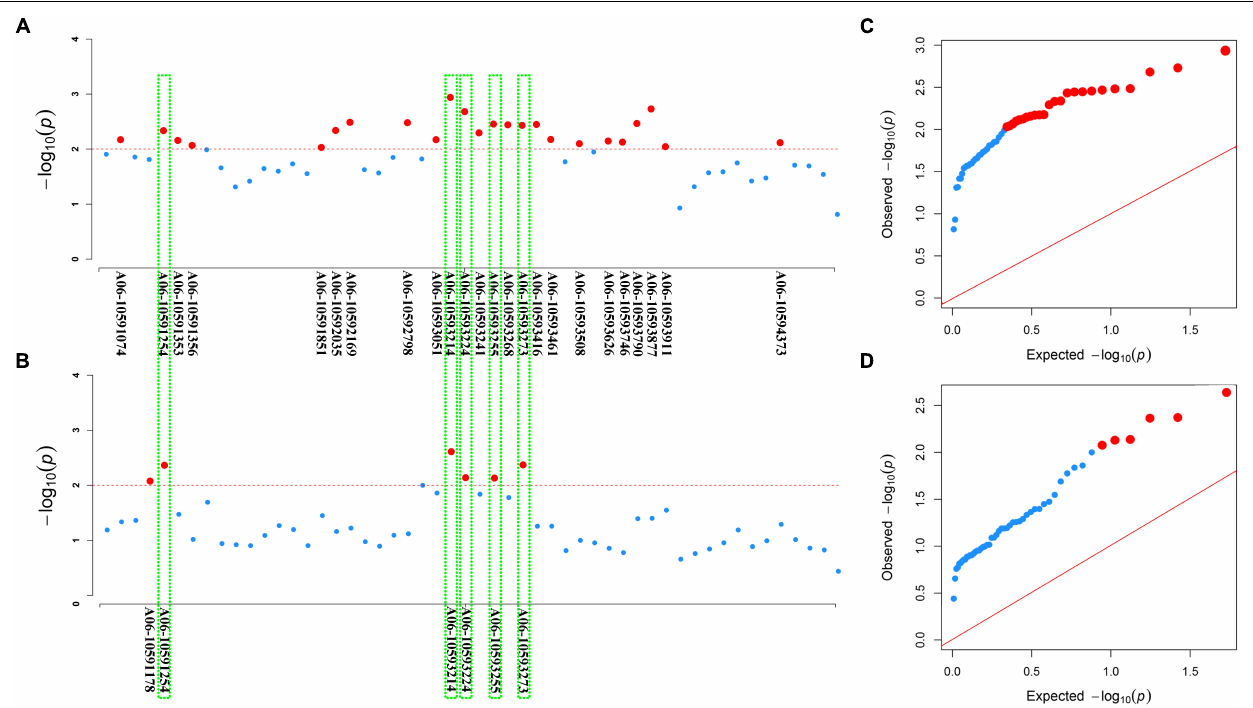
FIGURE 7 | Association of SNP polymorphisms with disease index or disease incidence rate across the BnaA06g18440D locus of BnaMPK3 . (A) Manhattan plot for disease index or (B) disease incidence rate. The threshold of association analysis was set to P < 0.01. The red-dotted line was –log 10 ( p ) = –log 10 (0.01) = 2.0, and the red dot above the red-dotted line represents a significantly associated SNP. The red dots in the green box are significantly associated SNPs for both disease index and disease incidence rate. (C) The Q–Q plots for disease index or (D) disease incidence rate from association analysis. The red line was the unbiased estimates of the expected and observed value. Red dots were the significant